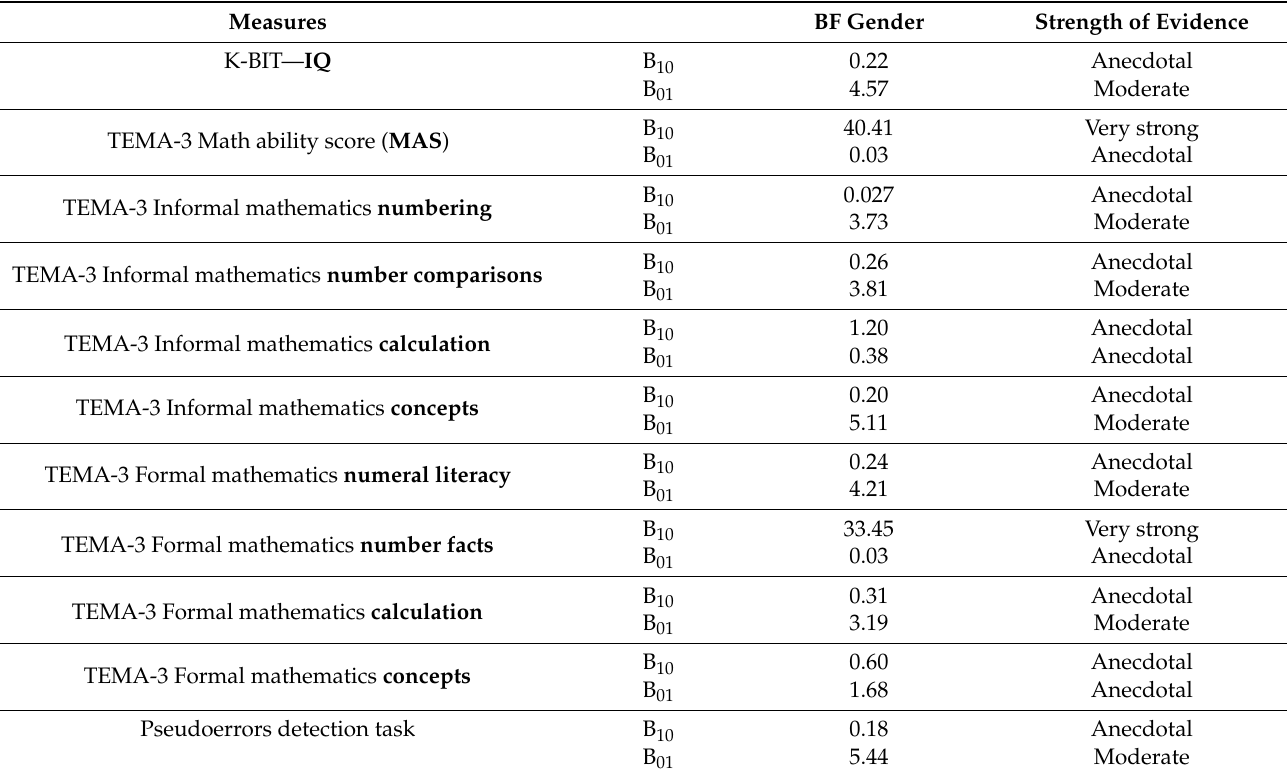
Table 6. Bayes factor for the main effect of